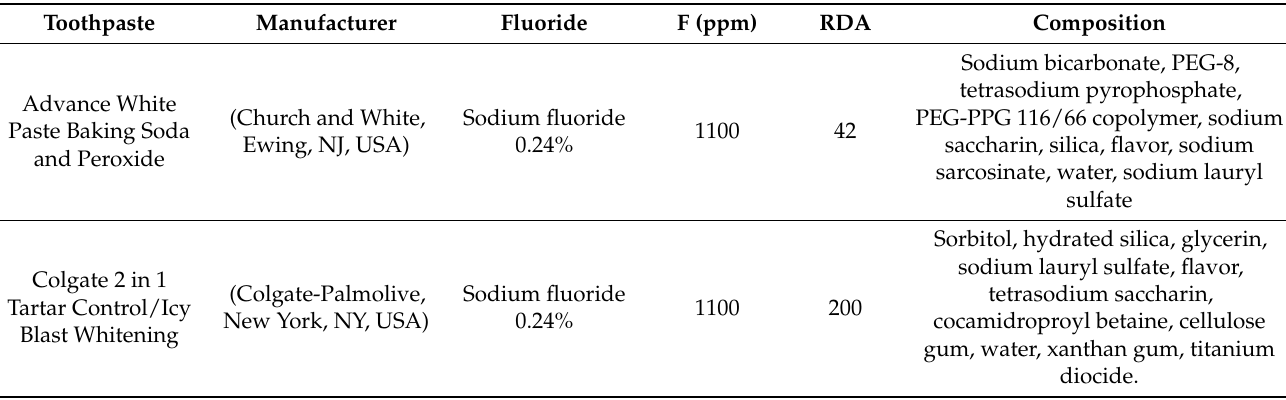
Table 3. Composition of the two toothpastes used for